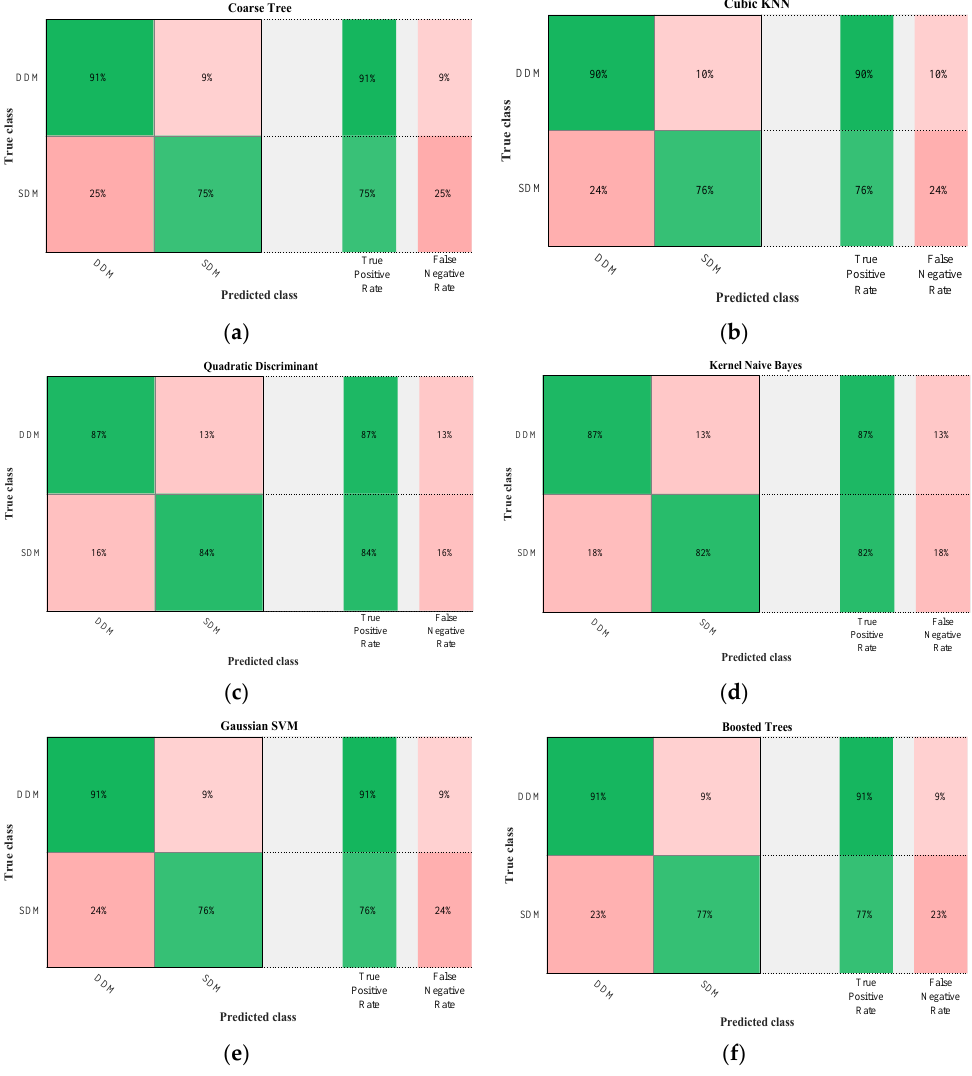
Figure 11. Confusion matrix related to six classification algorithms. ( a ) Coarse Tree; ( b ) Cubic KNN; ( c ) Quadratic Discriminant; ( d ) Kernel Naïve Bayes; ( e ) Gaussian SVM; ( f ) Boosted trees. The optimal operating points on the ROC curve for each classification model are plotted in Figure 12. The ROC curve for Naïve Bayes is generally lower than the other two ROC curves, which indicates worse in-sample performance than the other two classifier methods. By comparison of the area under the curve (AUC) for all classifiers, classification tree and SVM have the lowest AUC measure, meanwhile Naïve Bayes and quadratic discriminant have the highest AUC value. Therefore, the classification tree and SVM present high performance for the considered sample data.